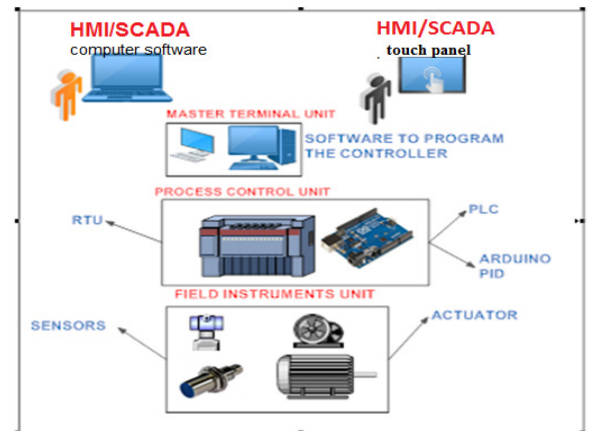
Fig. 1. SCADA Components .